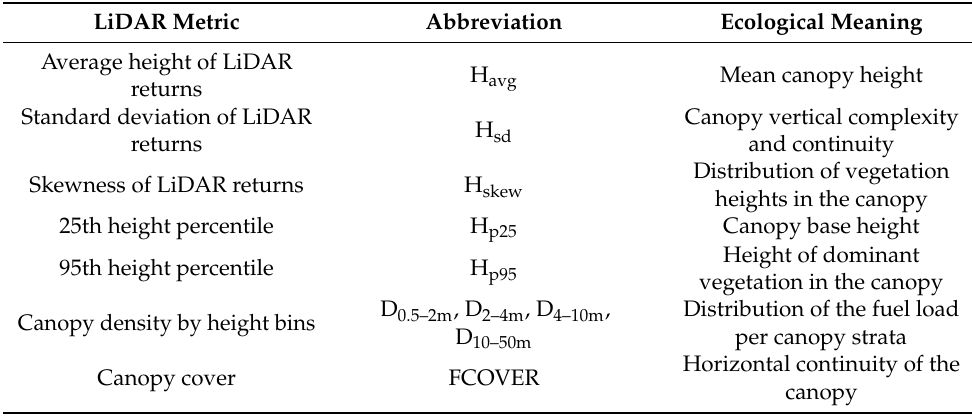
Table 1. Description of the LiDAR metrics considered in this